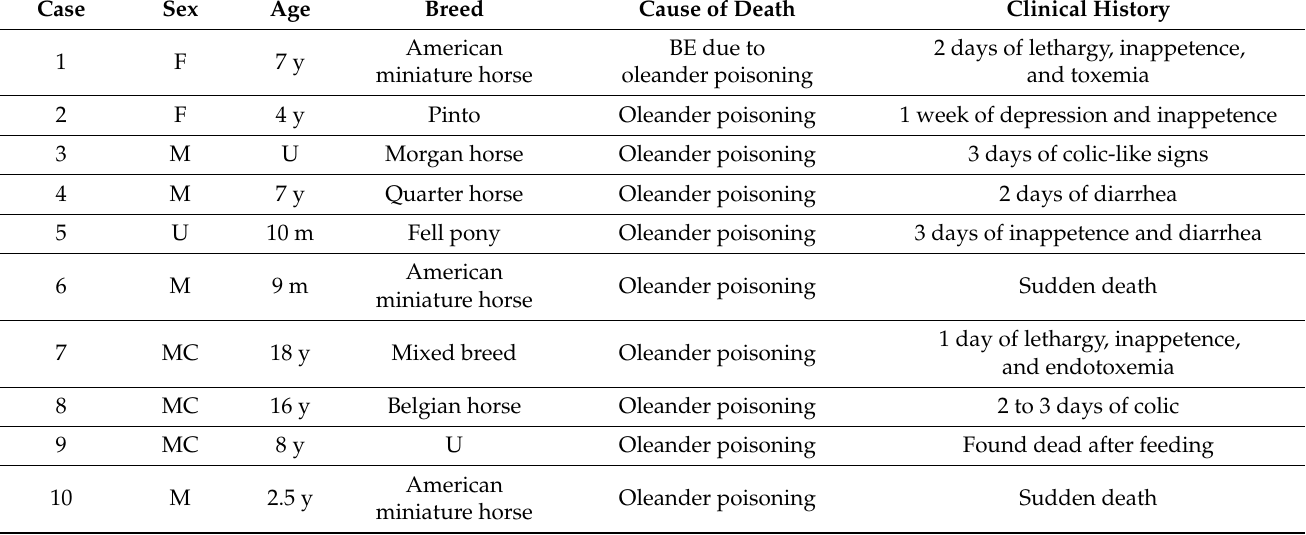
Table 1. Signalment, cause of death, and clinical history of horses with oleander poisoning and